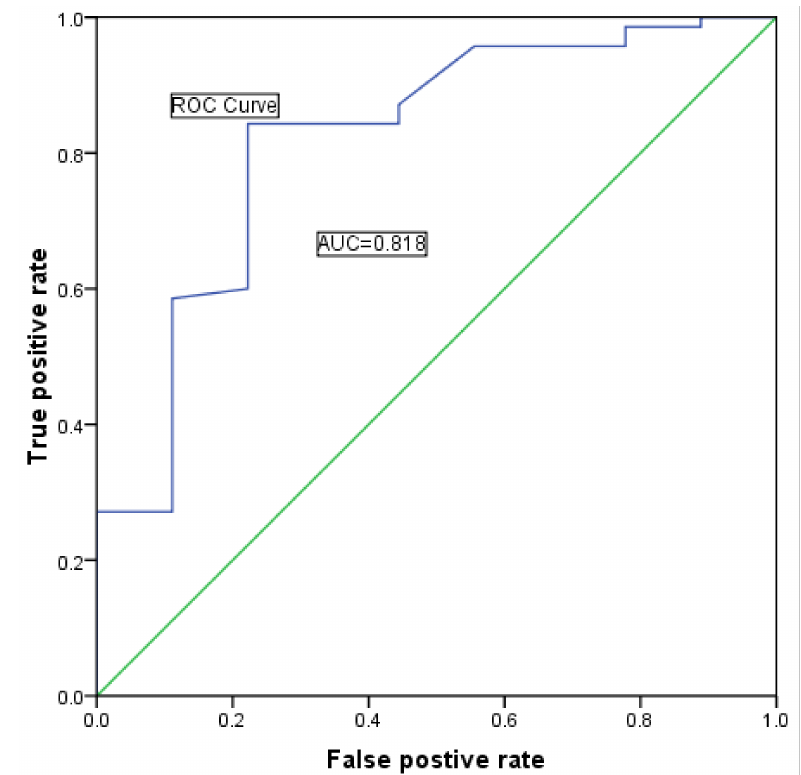
Figure 14. Receiver Operating Characteristics (ROC)